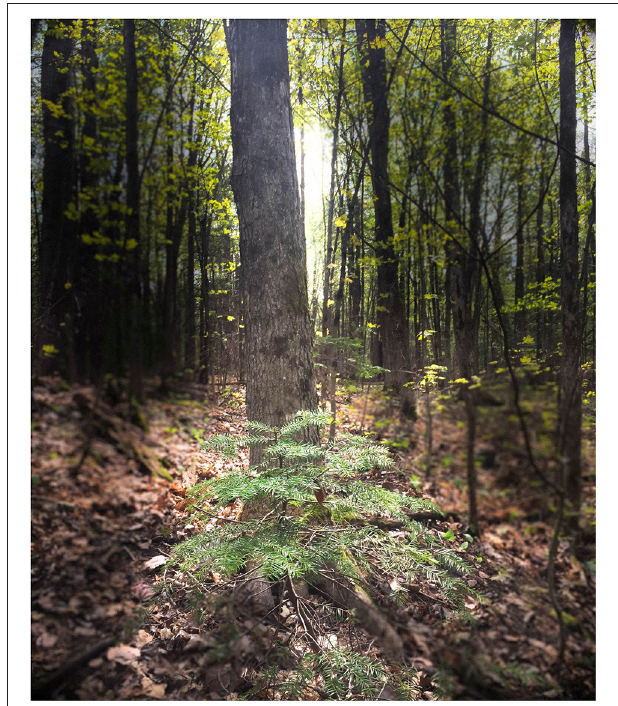
FIGURE 2 | Growing Up Small : As we transition into adulthood, we may feel small and insecure because of the lack of role models growing up. Perhaps our role models had difficulty holding on to life themselves because of their difficulties. So, we don’t feel equipped to deal with this big world and still see ourselves as small.